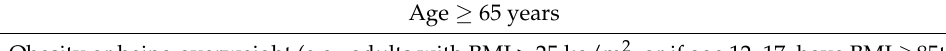
Obesity or being overweight (e.g., adults with BMI > 25 kg/m 2 , or if age 12–17, have BMI ≥ 85th percentile for their age and gender based on CDC growth charts) Pregnancy Chronic kidney diseases Diabetes Immunosuppressive diseases or immunosuppressive treatment Cardiovascular disease (including congenital heart disease) or hypertension Chronic lung diseases (e.g., chronic obstructive pulmonary disease, asthma, interstitial lung disease, cystic fibrosis and pulmonary hypertension) Sickle cell disease Neurodevelopmental disorders (e.g., cerebral palsy) or other conditions that confer medical complexity (for example, genetic or metabolic syndromes and severe congenital anomalies) Medical-related technological dependence (e.g., tracheostomy, gastrostomy, or positive